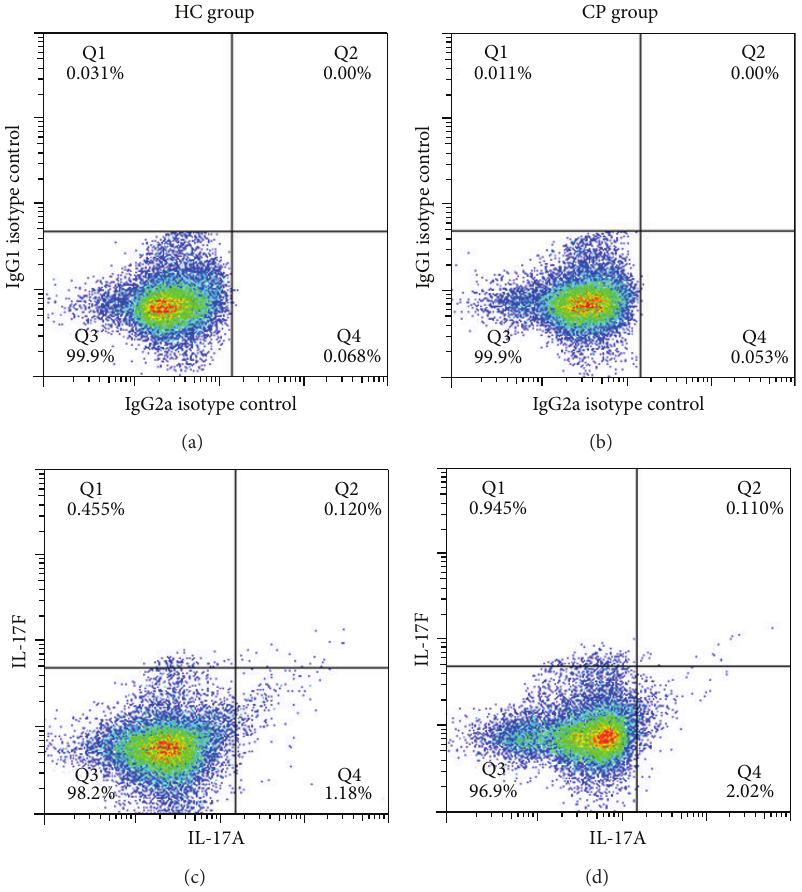
Figure 2: Representative dot blot showing percent expression level of (IL-17A + and/or IL-17F + ) Th17 cells in CP group ( 𝑛 = 30 ) and HC group ( 𝑛 = 25 ) within the CD4 + population. (a) and (b) showed the isotype control performed by Simultest IgG2a/IgG1, while (c) and (d) showed the double staining performed by IL-17A and IL-17F anti-human